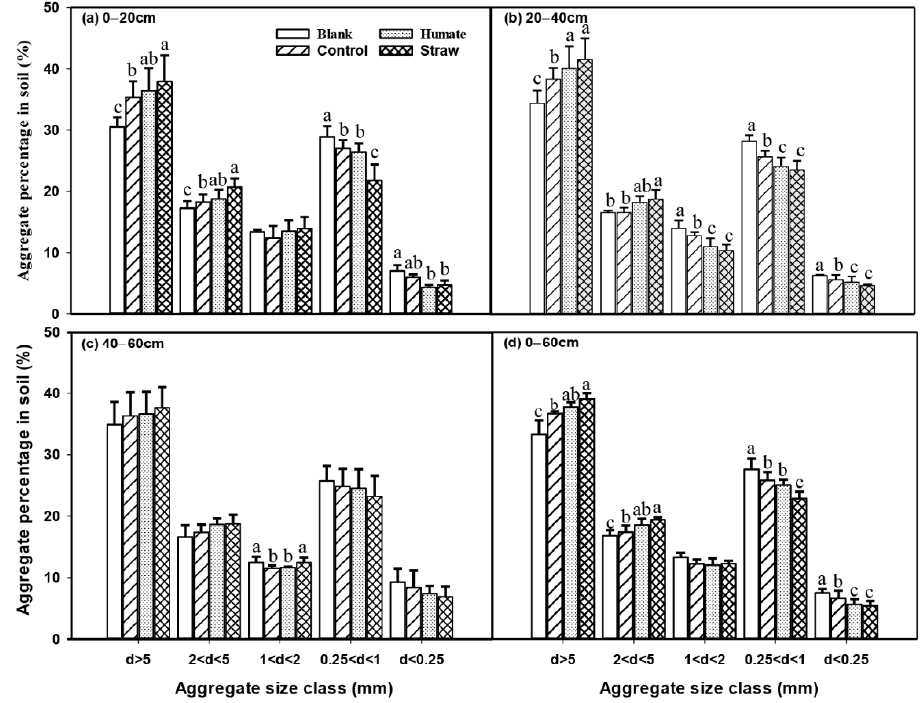
Figure 1. Percentage of soil aggregates (%) of different sizes in the soil layers 0–20 cm ( a ), 20–40 cm ( b ), 40–60 cm ( c ) and 0–60 cm ( d ) with dry sieving in 2018 after a 3-year trial. ( 1 ) Blank: bare ground, no agricultural treatment; ( 2 ) control: standard FM practice with standard fertilizer dose of 150 kg ha −1 N, 120 kg ha −1 P 2 O 5 , and 75 kg ha −1 K 2 O (serving as CK); ( 3 ) humate: FM plus humate, i.e., commercial humic organic fertilizer (granules) of 1500 kg ha –1 (organic matter/dry basis matter ≥45.0–55.0%, free humic acid/dry basis matter ≥20.0%); and ( 4 ) straw: FM with straw retention, i.e., 7500 kg ha –1 air-dried corn straw. Significant differences are indicated by lowercase letters (a, b, c) according to LSD’s test at p < 0.05 level. Error bars represent the standard deviation (SD).